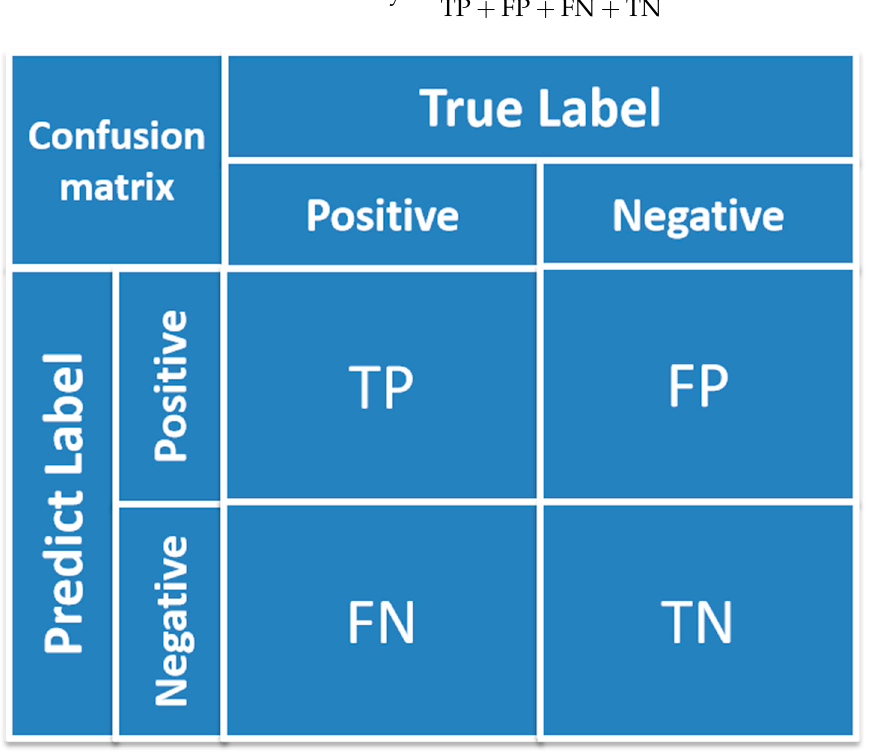
Figure 1. The presentation form of confusion matrix.